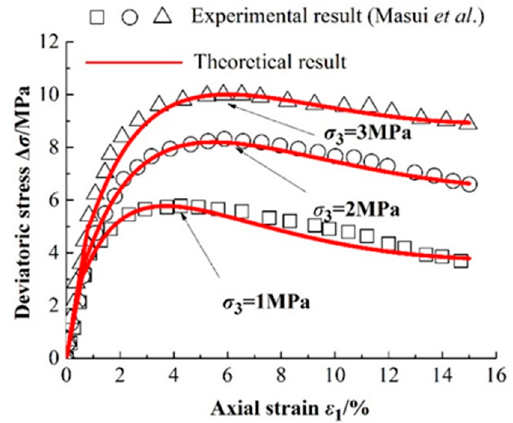
Figure 2. Comparisons of stress–strain theoretical curves and test curves of hydrate-bearing sediments under different hydrate saturations. ( a ) S h = 0%; ( b ) S h = 25.7%; ( c ) S h = 40.7%; ( d ) S h = 55.1%.